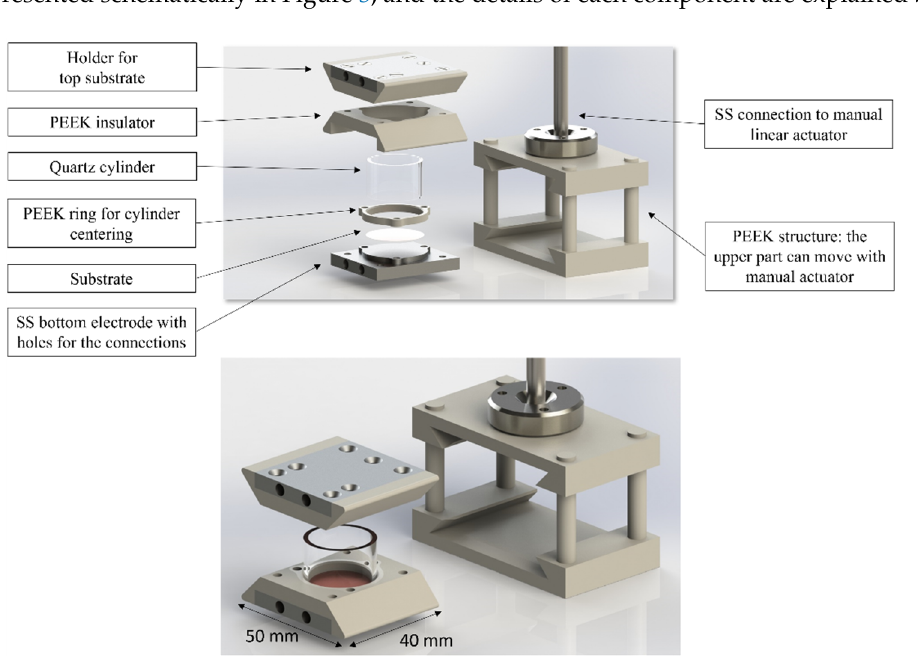
Figure 3. Rendering of the sample holder with the description of each component.